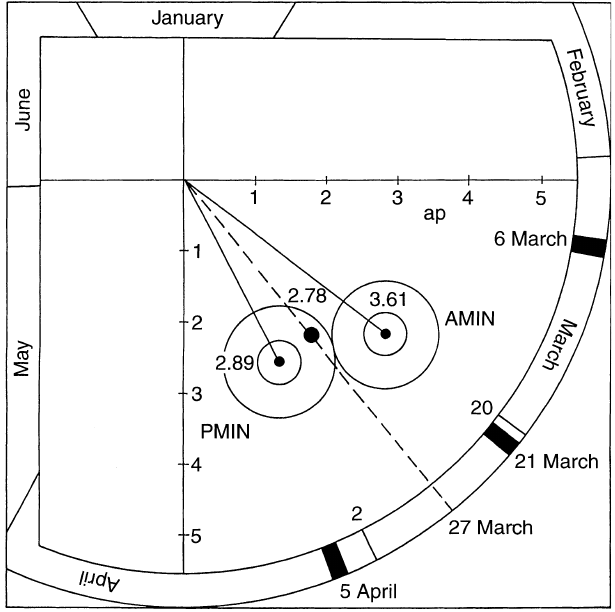
Fig. 5. Harmonic dial showing the amplitude and phase of maximum for the semiannual wave of the two averaged spectra shown in Fig. 4, AMIN and PMIN before and after sunspot minimum, respectively, and the average semiannual wave of Ap for the years 1933–1993. The large circles denote the probable errors for the single values, the small circles denote the errors of the averages